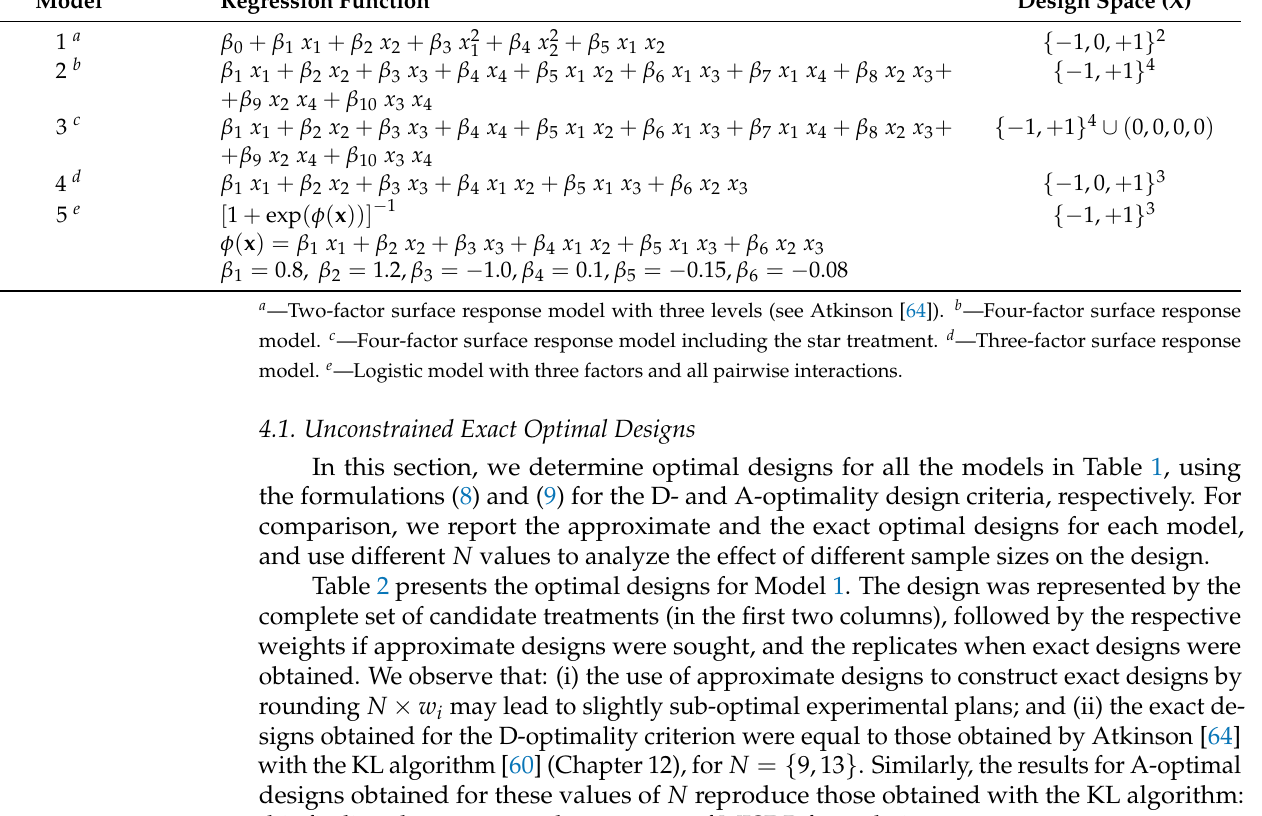
Table 1. Statistical models used for testing the MISDP formulations. Model Regression Function Design Space